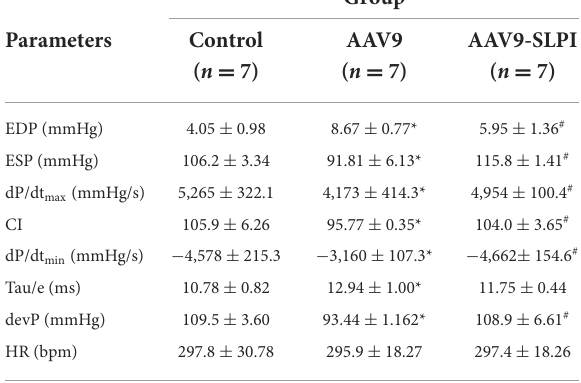
TABLE 1 Baseline LVP parameters.